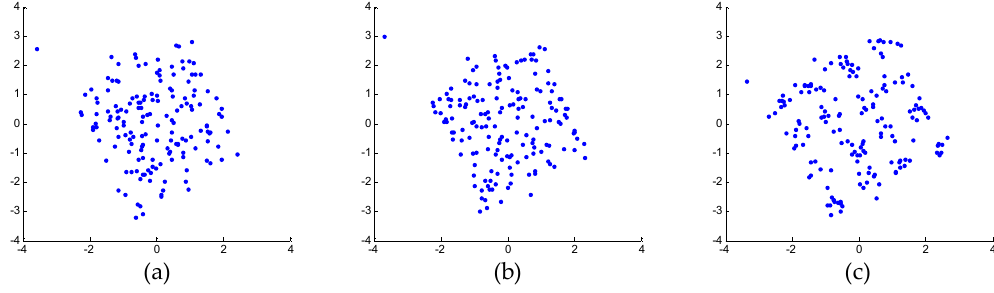
Figure 16. Demodulated constellations of the weak 16-QAM signals: ( a ) unmitigated signal; ( b ) output of AIC algorithm; ( c ) output of the proposed algorithm.